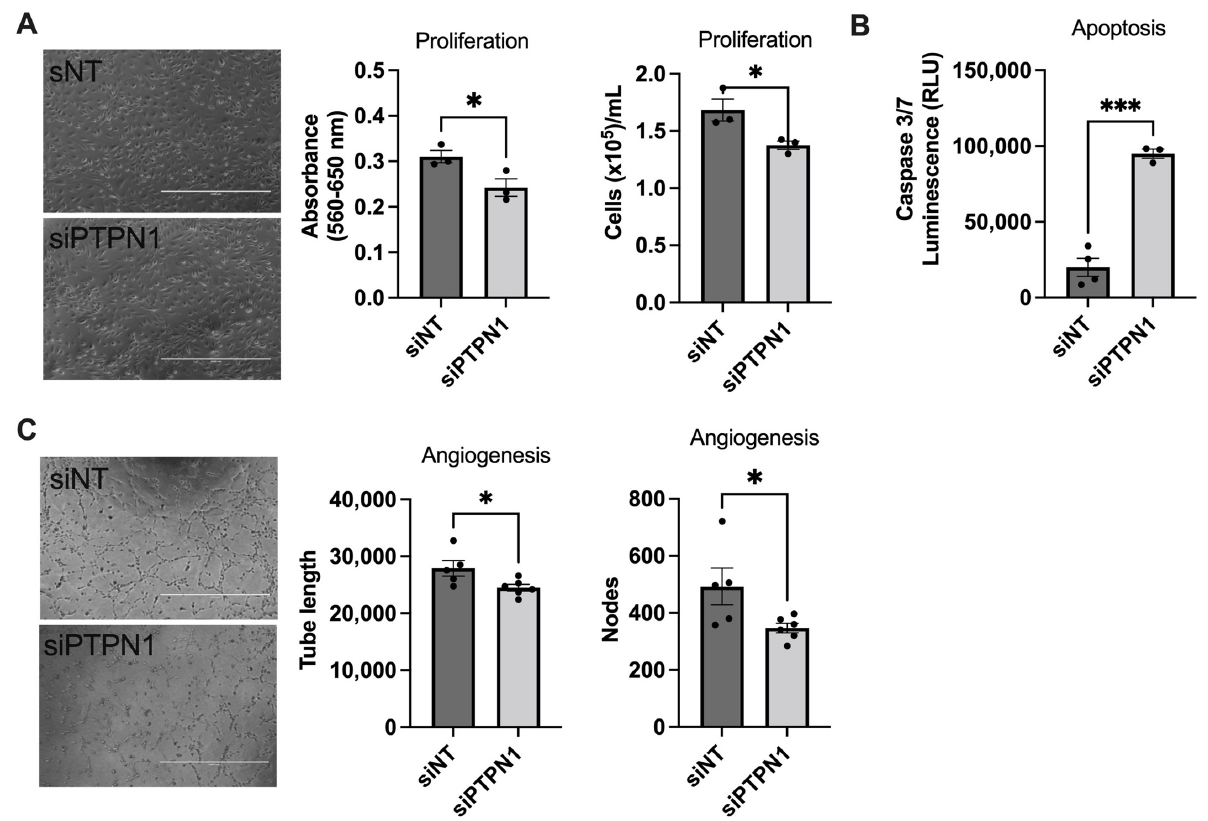
Figure 2. PTPN1 deficiency induced endothelial dysfunction in PAECs. ( A ) siRNA-mediated knockdown of PTPN1 showed decreased PAEC viability, as assessed by MTT assay and hemocytome- ter countings. ( B ) PTPN1 silencing induced apoptosis, as evidenced by increased caspase 3/7 levels in PAECs. ( C ) PTPN1 silencing decreased ability of PAEC tube formation in a Matrigel tube formation assay. Angiogenesis was quantified in the images using ImageJ software. Total tube lengths were presented in µ m. The number of nodes were counted in the analyzed area. Scale bar = 1000 µ m. Data represented as mean ± SEM ( n = 3–6), student t-test. * p < 0.05, *** p <